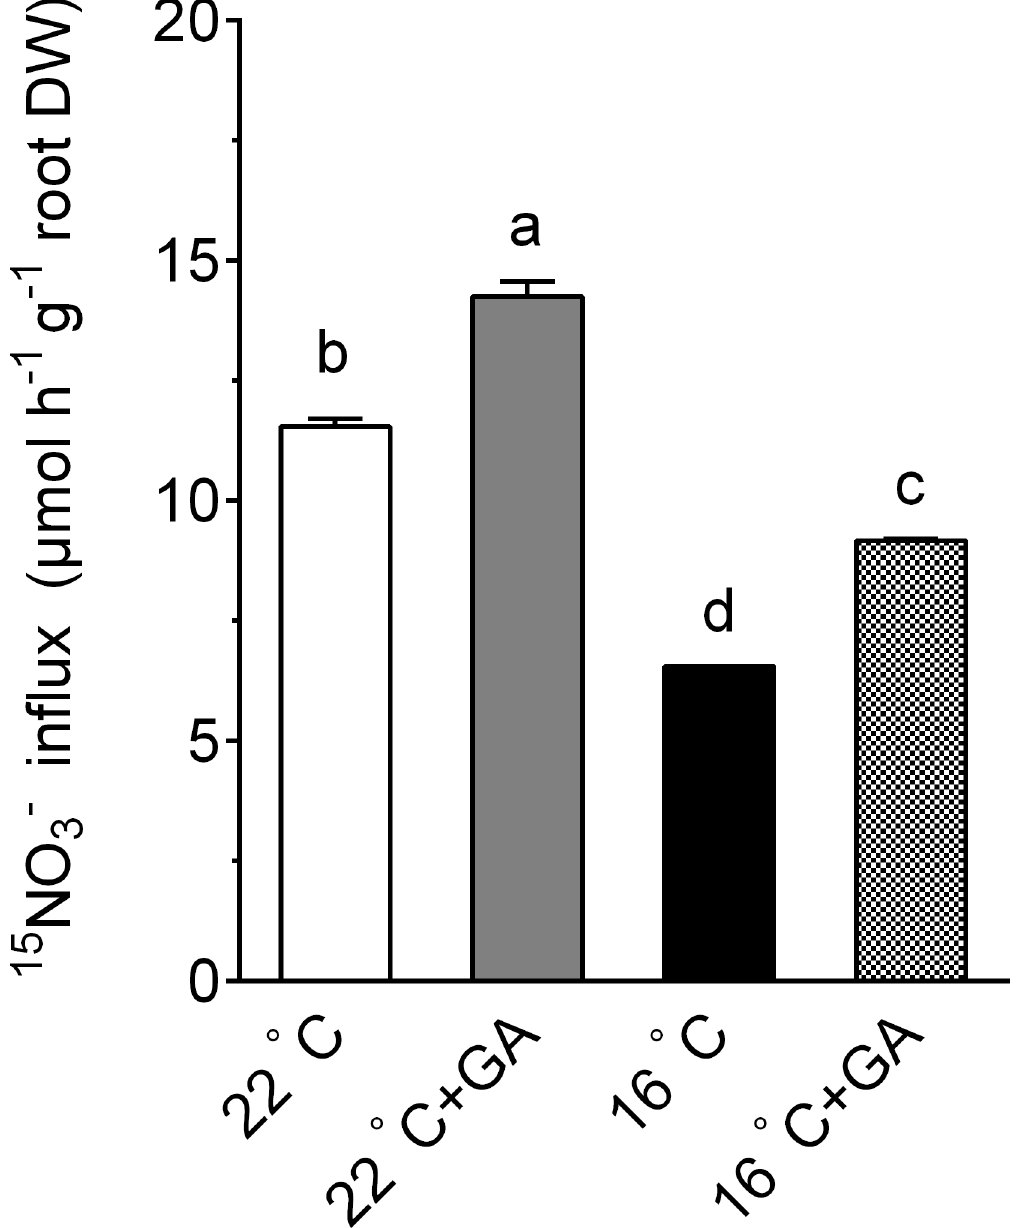
Fig 4. Effect of suboptimal T r and GA on 15 NO 3- influx of cucumber. 15-day-old cucumber seedlings were transferred to 22°C T r and 16°C T r conditions in the presence or absence of GA 5 μ M GA for 8d. Data are means ± SE. Different letters on the top of column indicate significant differences ( P < 0 . 05 , n = 3).